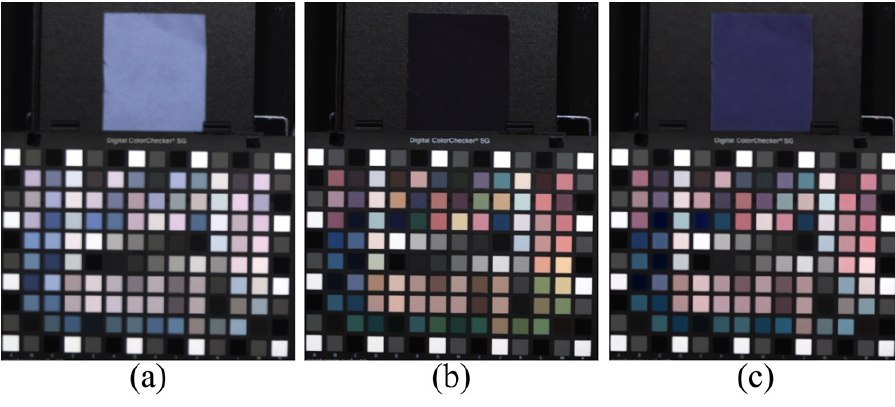
Figure 7. Example of the conventional color correction method for the MSFA image. ( a ) MSFA image without IRCF; ( b ) MSFA image with IRCF; ( c ) color correction